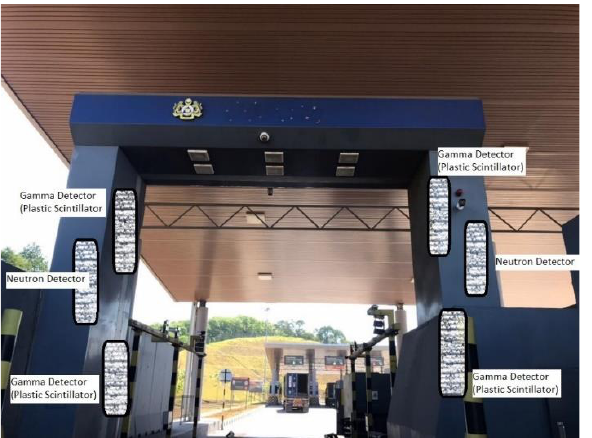
Figure 3. A radiation portal monitor at customs and immigration check point Bukit Kayu Hitam, Kedah, Malaysia.